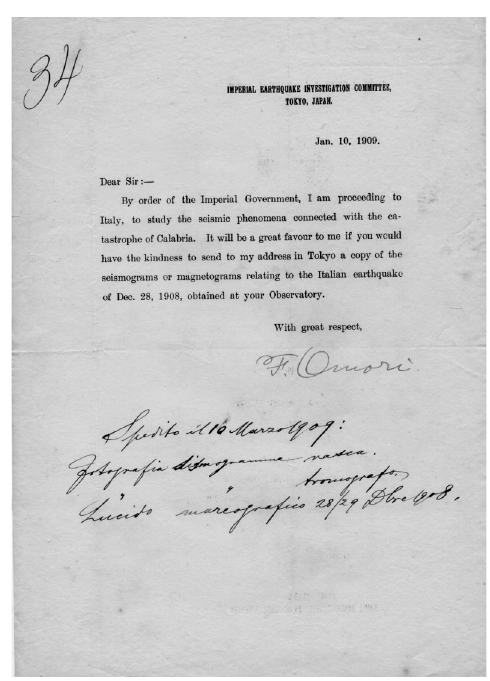
Fig. 3. Circular letter of Omori to Grablovitz with the request for copies of seismograms and magne- tograms connected with the earthquake of the Straits of Messina on 28th December 1908. A handwritten note of Grablovitz specifies that on 10th March 1909 copies of the seismograms were sent and a glossy calqued copy of the mareogram (Grablovitz